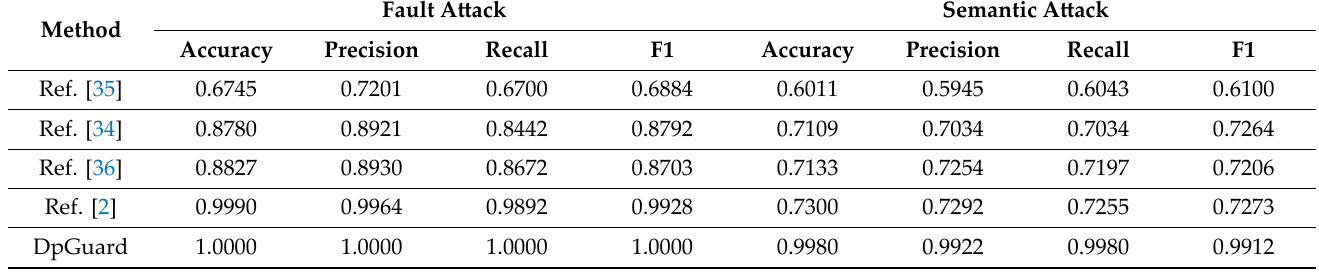
Table 5. Test results and comparison.